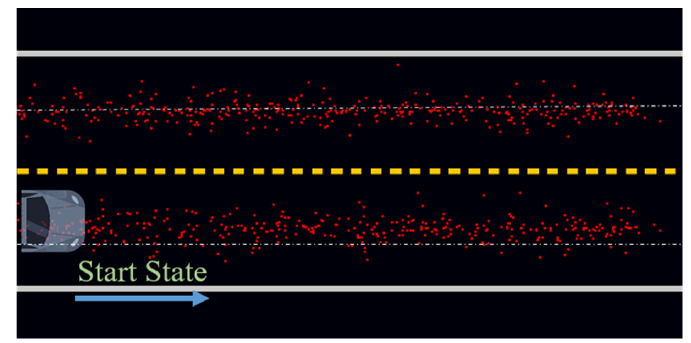
Figure 7. Gaussian distribution sampling.